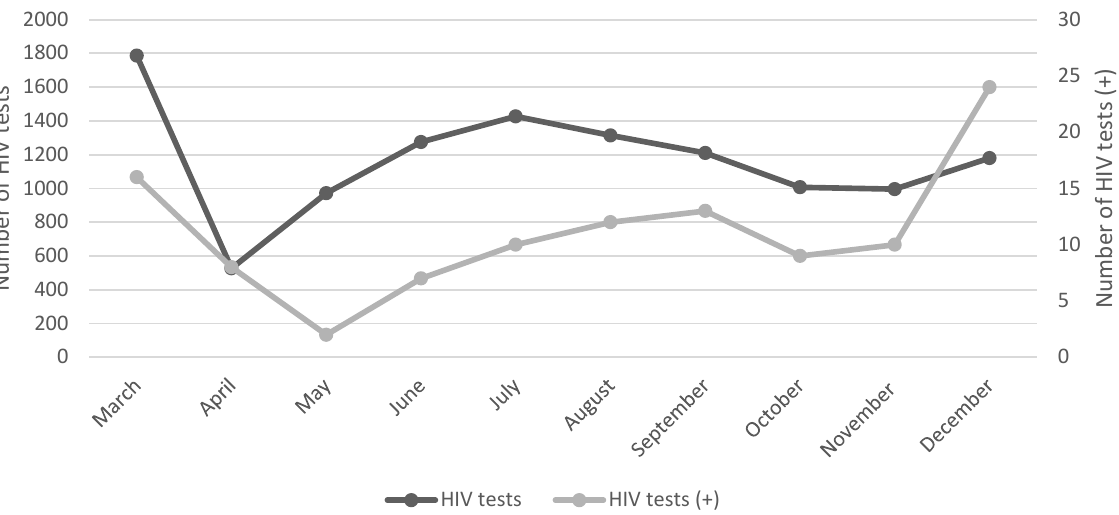
Figure 4. Line graph presenting the monthly number of HIV tests and positive HIV tests (+) for children under 15 years of age in 2020. The number of positive HIV tests followed the trend of the number of HIV tests being conducted. A significant decrease in testing and positive tests was seen for the months of April and May, coinciding with the start of the first wave of COVID-19 cases in South Africa. A monthly increase in testing and positive tests was seen throughout the year, however, it did not increase pre-lockdown levels. The number of children < 15 years of age testing positive for HIV significantly increased between November and December. This figure was created using data from Mutyambizi et al., 2021 [26]. (HIV = Human Immunodeficiency Virus).